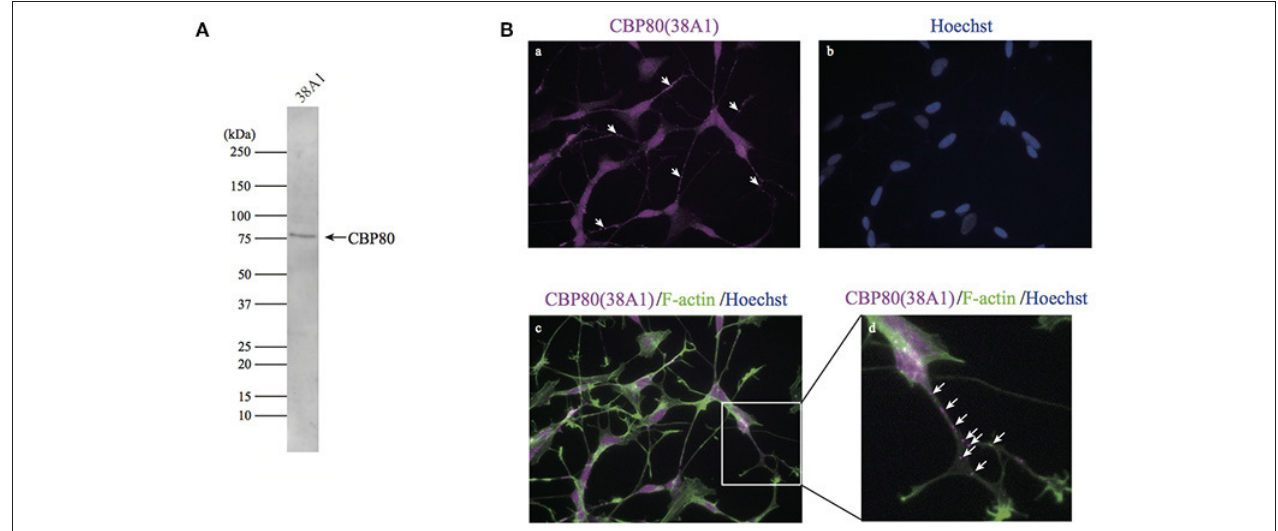
FIGURE 1 | CBP80-positive puncta in differentiated SH-SY5Y cells. (A) Western blot analysis of SH-SY5Y lysate with monoclonal antibody 38A1 raised against human CBP80. (B) Microimages of SH-SY5Y cells stained with 38A1 (a) and Hoechst (b) . (c) Microimages of SH-SY5Y cells co-stained with 38A1 antibody (magenta) and Phalloidin-fluorescein (green). (d) Enlarged image of white box in (c) . Arrows indicate CBP80 granules in neuronal processes.